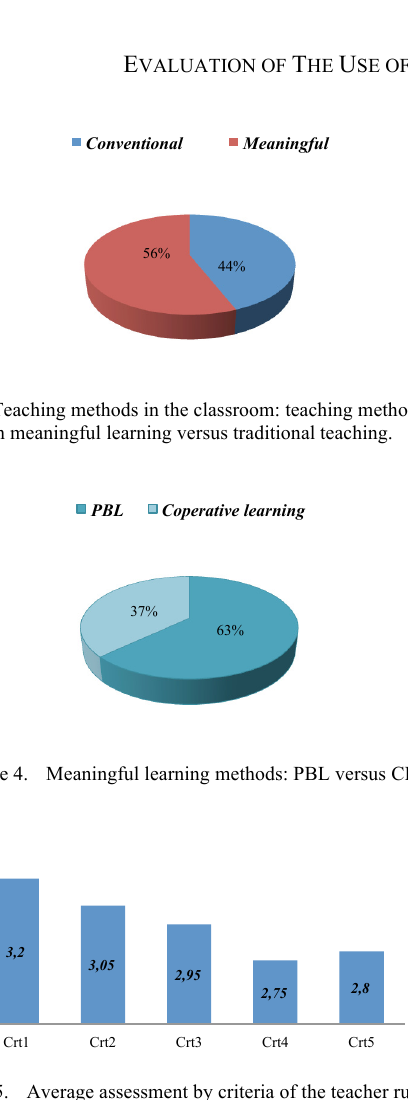
Figure 5. Average assessment by criteria of the teacher rubric